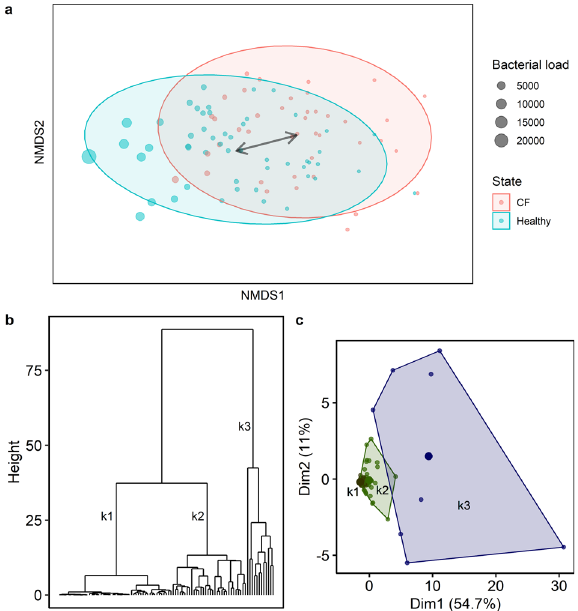
Fig. 3 Clustering analyses to identify known and unknown patterns, which in fl uence microbial community pro fi les in children. a Non-metric multidimensional scaling based on Bray – Curtis dissimilarity matrices identi fi ed massive overlap between healthy and CF microbial community pro fi les. The bacterial load (absolute abundance) indicates the number of bacterial cells per human cell. b Hierarchical clustering (Ward ’ s clustering algorithm) based on Euclidean distances revealed three main groups of microbial community pro fi les in children between 0 and 6 years of age. c The group pattern was con fi rmed by principal component analysis (PCA). The PCA plot contains the fi rst and second principal components as x - and y -axis, respectively. All core species contribute equally to the variance observed in the PCA, for example Streptococcus oralis explains 4.8% of the variance, R. mucilaginosa 4.7%, V. parvula 4.7%, Streptococcus parasanguinis 4.7%, Fusobacterium periodonticum 4.6% and so on (Supplementary Table